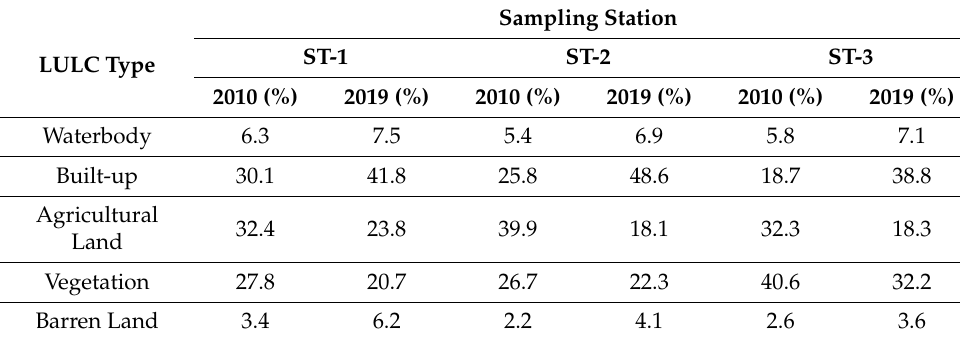
Table 5. LULC change within the 1000-m buffer zone of sampling stations.